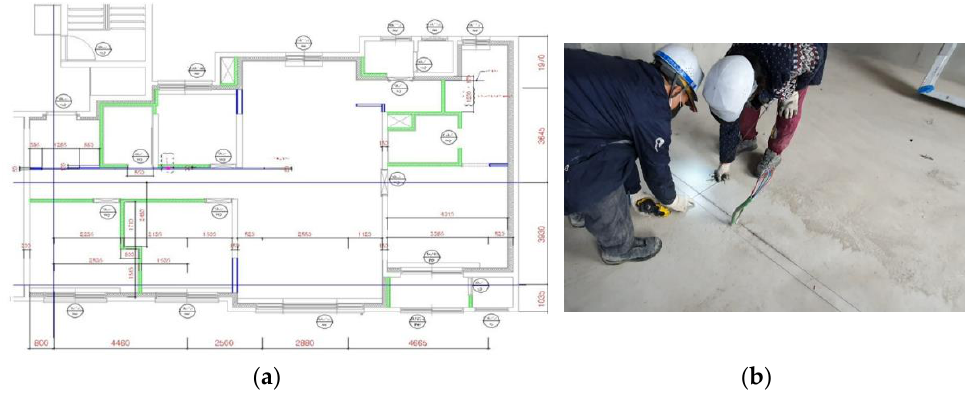
Figure 2. Layout printing: ( a ) layout printing of a floor plan; ( b ) photo of actual work.